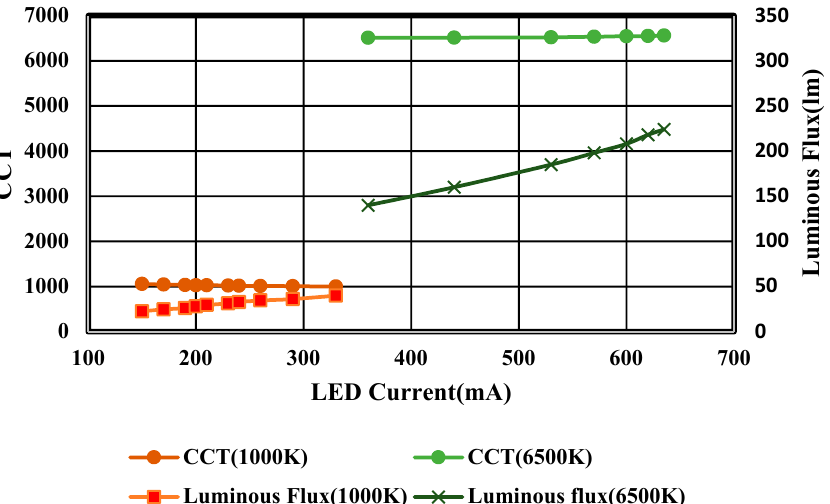
Figure 6. Measured CCT and luminous flux vs. LED current for CCT 1000 K and 6500 K LEDs.